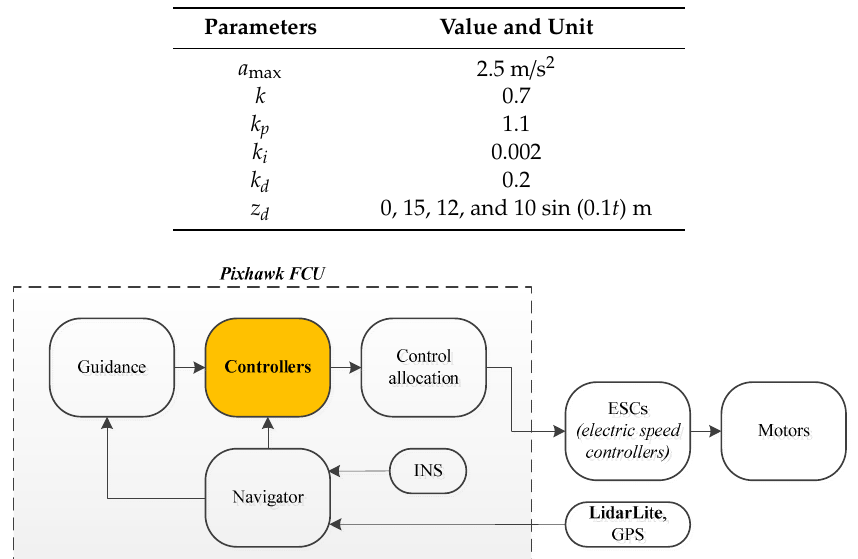
Table 2. Controller parameters and the altitude references.